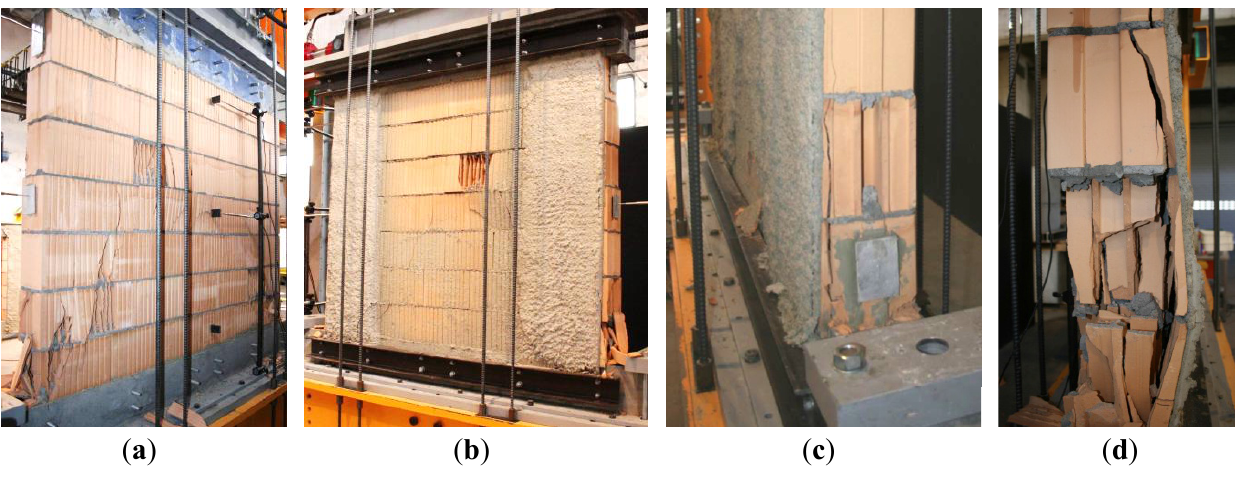
Figure 7. State of stress in retrofitted masonry